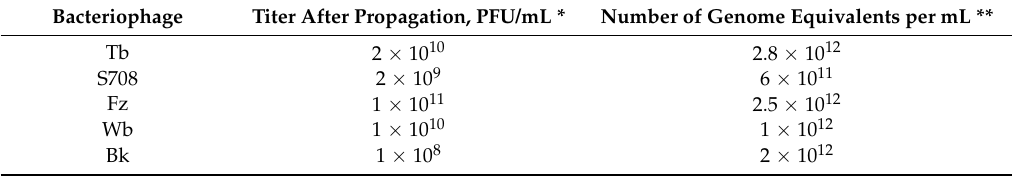
Table 1. Brucellaphage propagation: quantification by live counts and quantitative PCR (qPCR). Bacteriophage Titer After Propagation, PFU/mL * Number of Genome Equivalents per mL